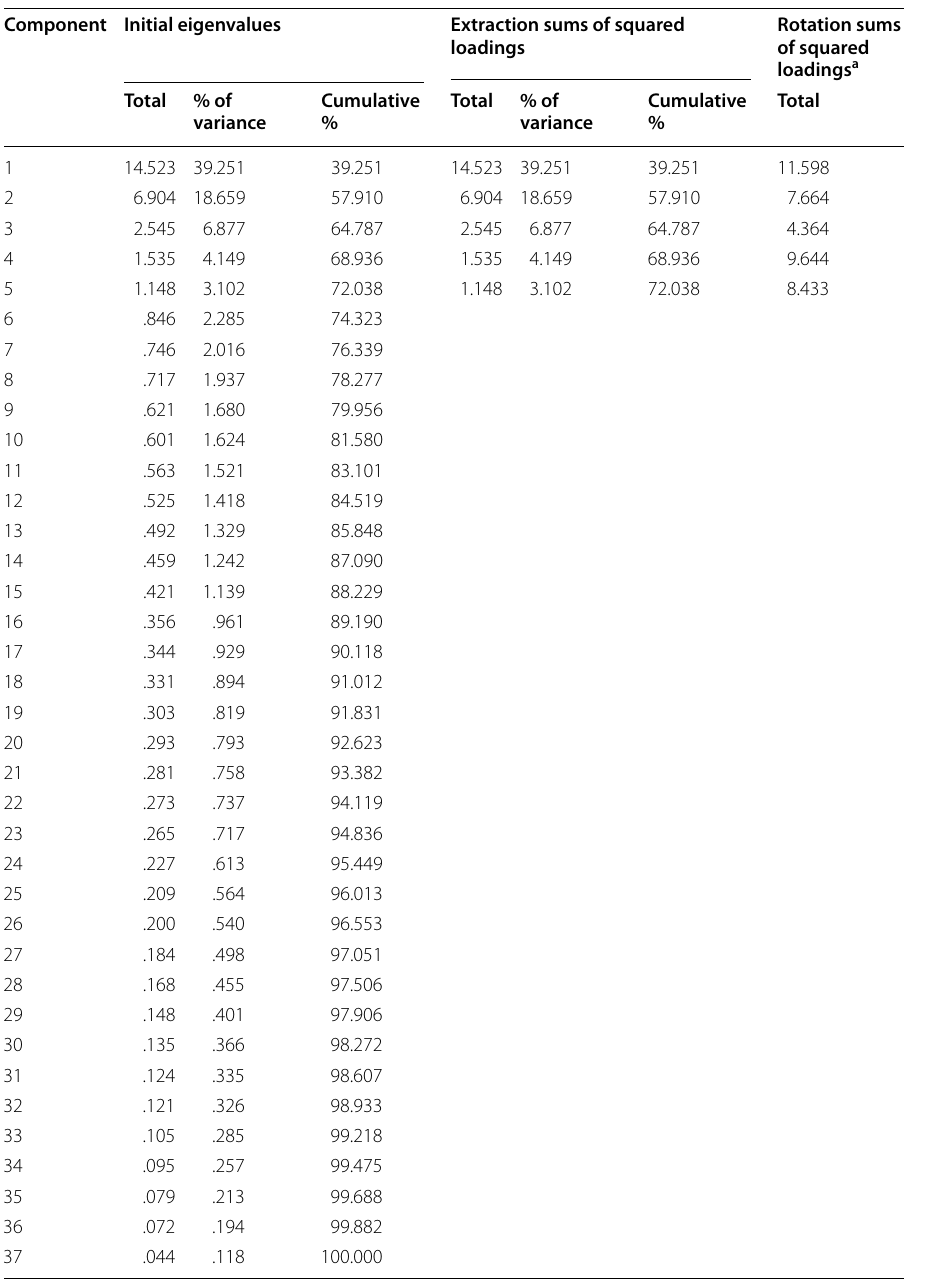
Table 2 Principal component analysis on